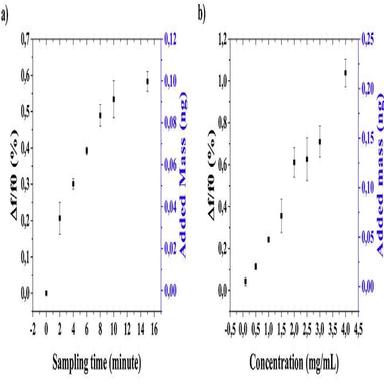
Dependency of relative frequency shift and calculated added mass on (a) sampling time for paracetamol solution of 2 mg/mL and (b) concentration of paracetamol solution for 10 min sampling time. Data is presented as mean ± SD (n = 5).